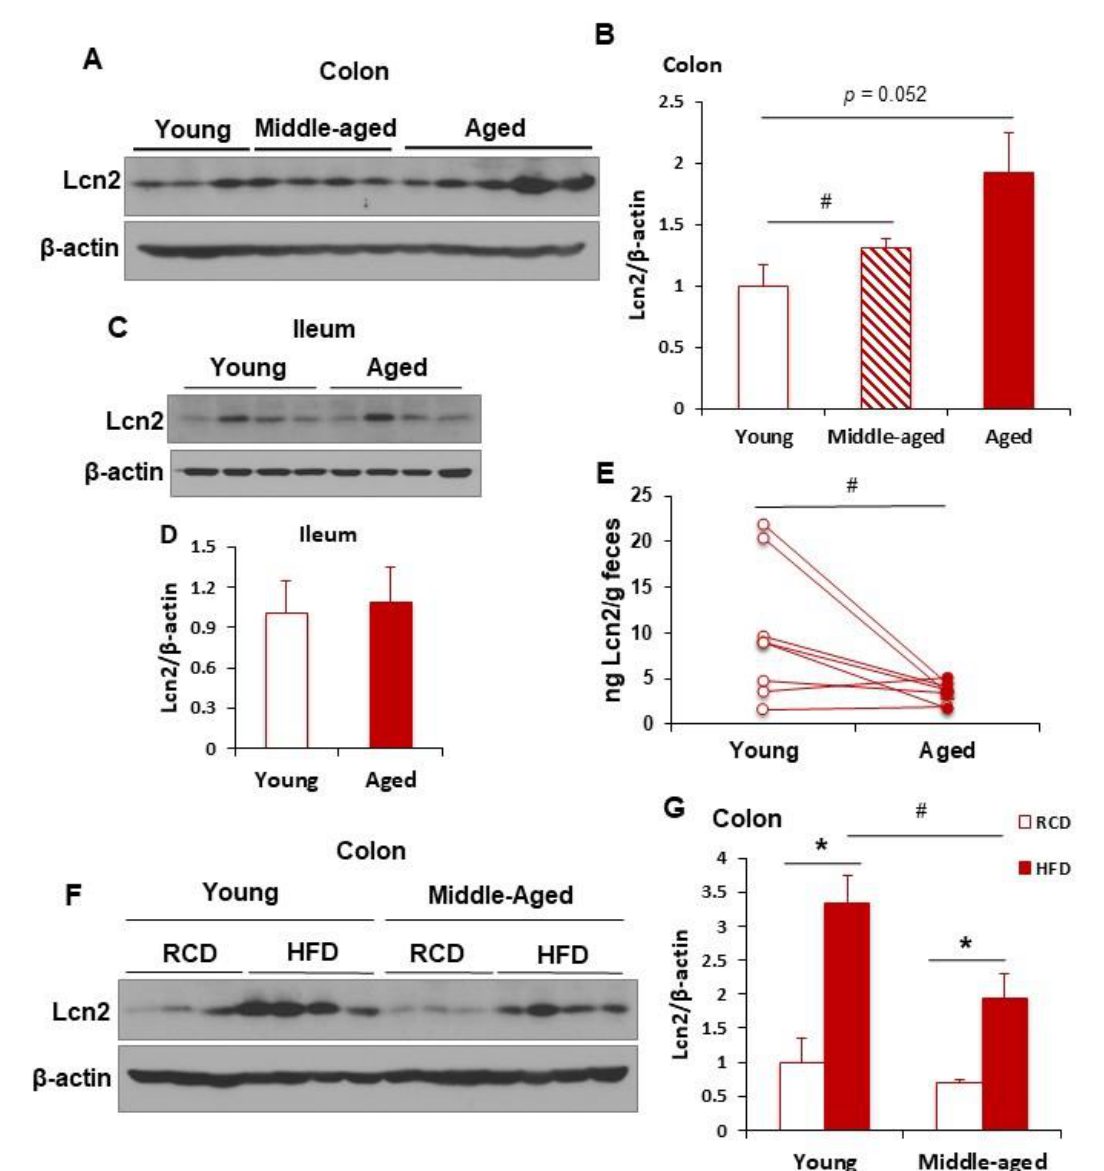
Figure 1. Regulation of Lcn2 expression and secretion in the gut during aging. ( A , B ) Male mice were fed an RCD and euthanized at the ages of 4 months (young), 10 months (middle-aged), and 18 months (old). Colon tissues were collected and homogenized in RIPA buffer. Lcn2 protein levels were determined by Western blotting ( A ) and quantified by ImageJ ( B ). ( C , D ) Male mice were fed an RCD and euthanized at the ages of 6 months (young) and 18 months (old). Ileum tissues were collected and homogenized in RIPA buffer. Lcn2 protein levels were determined by Western blotting ( C ) and quantified by ImageJ ( D ). ( E ) Fecal Lcn2 levels were measured using an ELISA kit. ( F , G ) Male mice at the ages of 2 months (young) and 11 months (middle-aged) were fed an HFD for 8 weeks. Colon tissues were collected for the detection of Lcn2 protein levels by Western blotting ( F ) and quantified by ImageJ ( G ). Data are presented as mean ± SEM. * p < 0.05 versus RCD-fed mice or as indicated. # p < 0.05 versus young